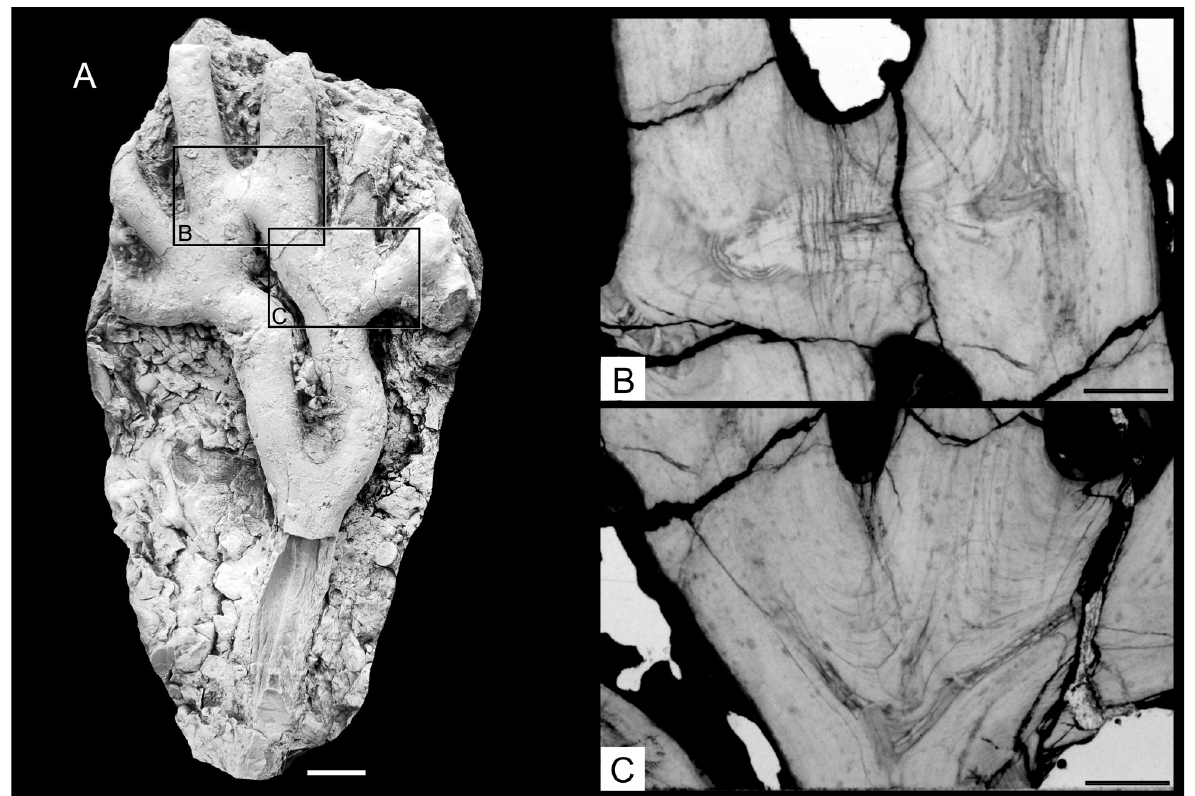
Fig 8. A—Fragmentary preserved fan shaped colony of Oligophylloides sp.–specimen UAM/He/B/030. Note: Reconnection of two neighbouring branches is well visible. Scale bar 5 mm; B–thin section of the fragment showing internal structure of the reconnection of the branches; C–thin section of the point of divergence of the branches. Scale bars for B and C 2